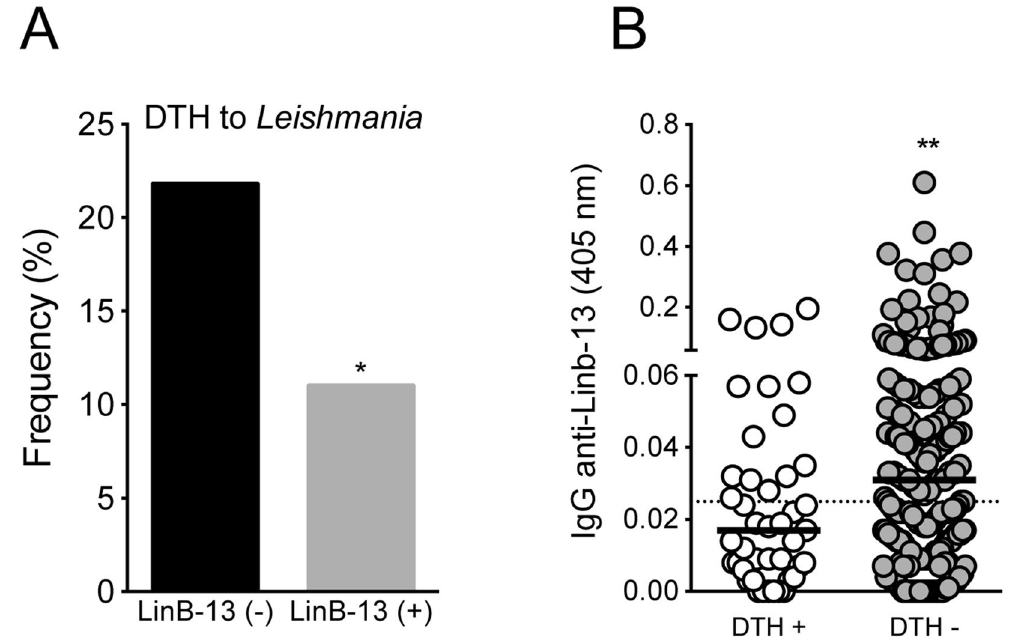
Figure 7. Lower response to Leishmania antigen in seropositive subjects to LinB-13. ( A ) Frequency of DTH reaction in subjects with positive or negative serology to LinB-13. ( B ) Total IgG response against LinB-13 was measured by ELISA in residents of a CL-endemic area who had positive (n = 43) or negative (n = 221) DTH to Leishmania . Data are shown individually. Black lines represent the median OD values for each group of individuals. * P < 0.05; ** P <